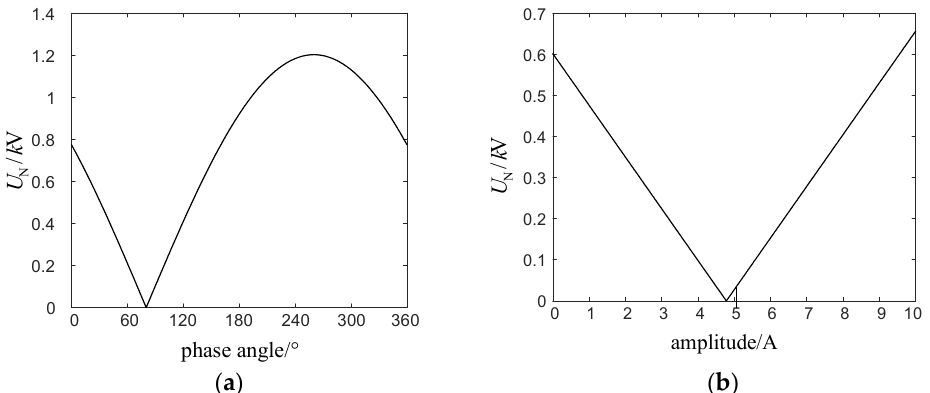
Figure 5. Relationship between the U N and the amplitude of I i : ( a ) phase angle of I i is 80.2°; ( b ) the amplitude of I i is 4.78 A.